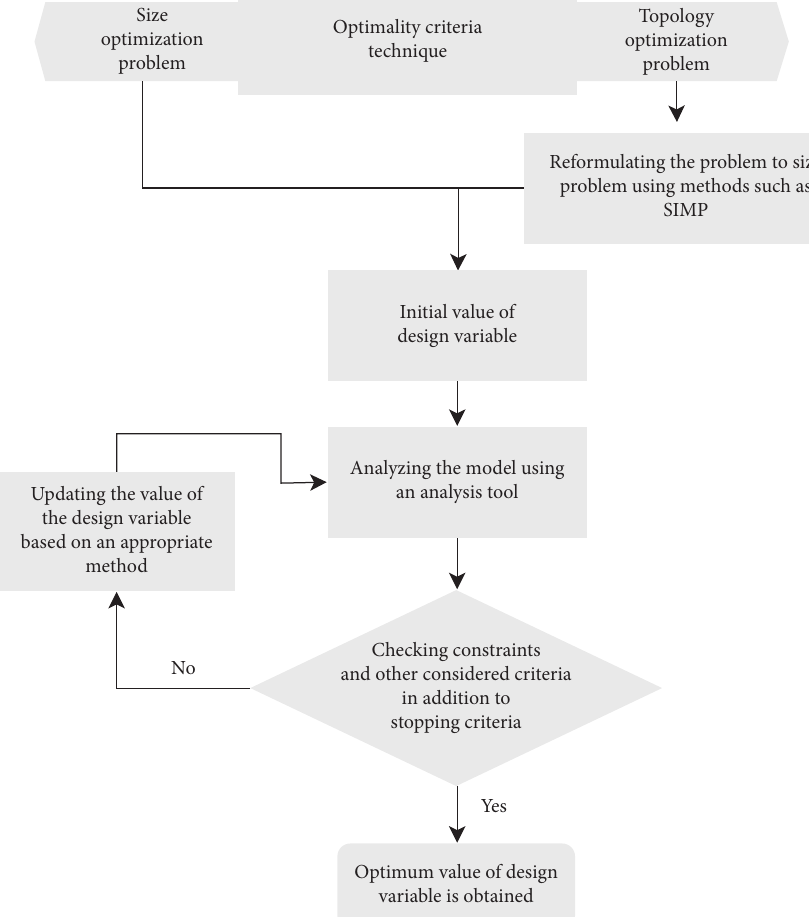
Figure 12: Optimality criteria